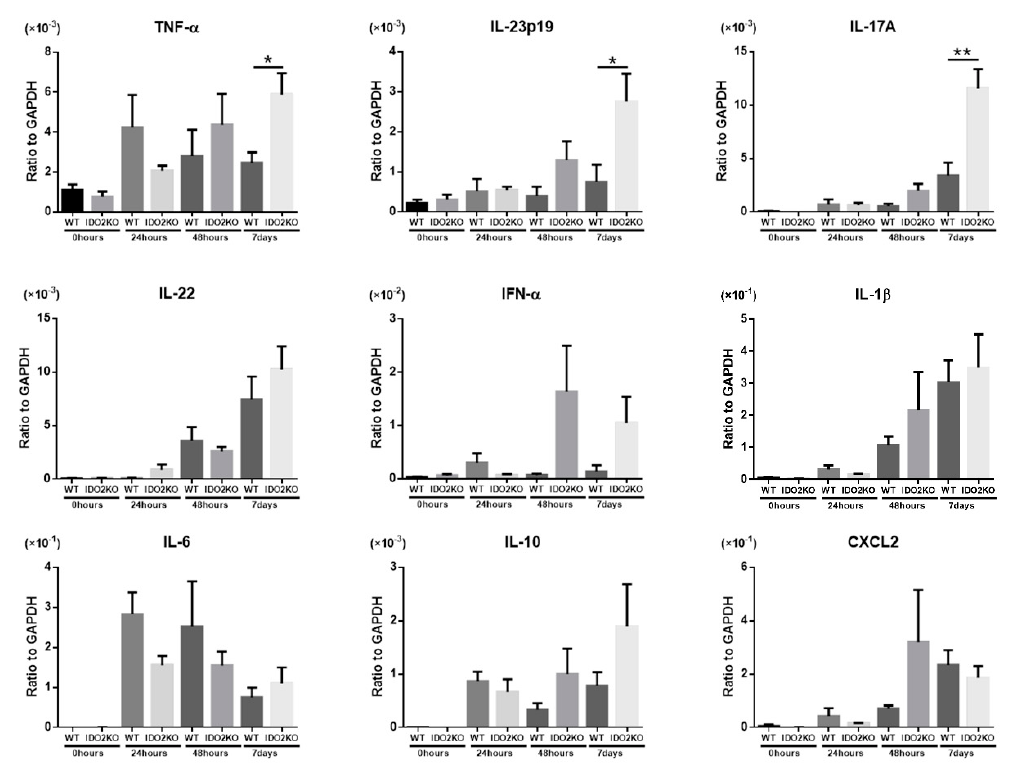
Figure 3. The deletion of IDO2 affects the mRNA expression of key cytokines involved in the pathogenesis of psoriasis. Quantitative real-time PCR analysis of the ear before and 24 h, 48 h, and 7 days after IMQ treatment. Data are presented as mean ± SEM. * p < 0.05, ** p < 0.01 (Student’s t -test).